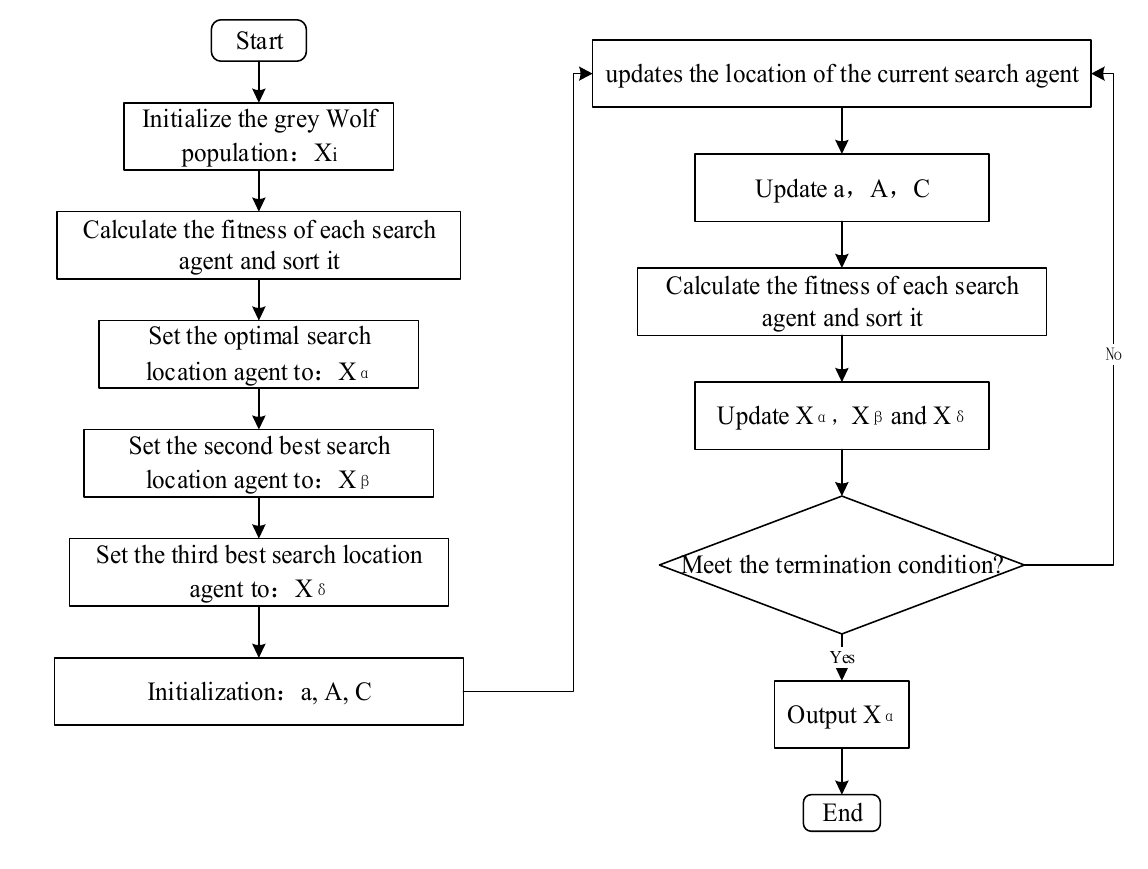
Figure 3. GWO algorithm fl ow chart.